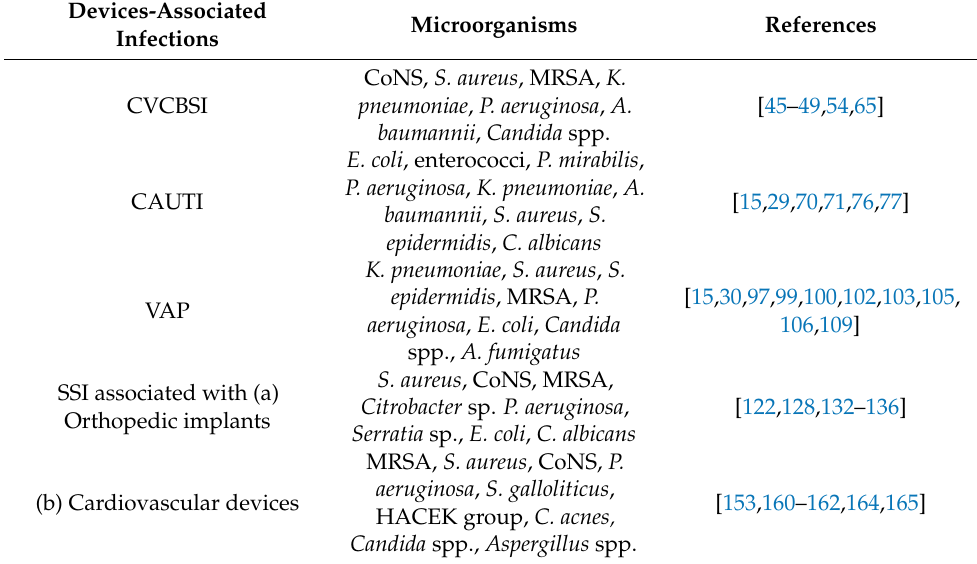
Table 1. Summary of the most frequent HAIs connected to medical devices and associated